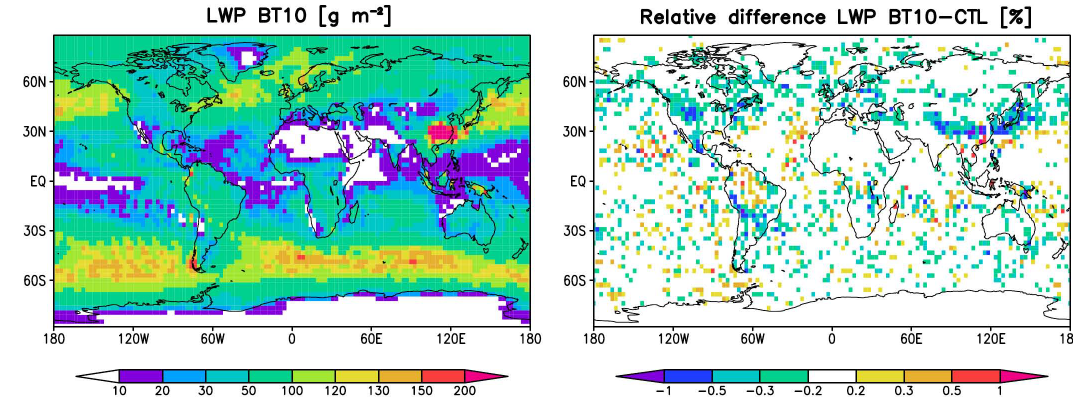
Fig. 10. Modelled annual global mean liquid water path (LWP), and the difference between BT10 and CTL.